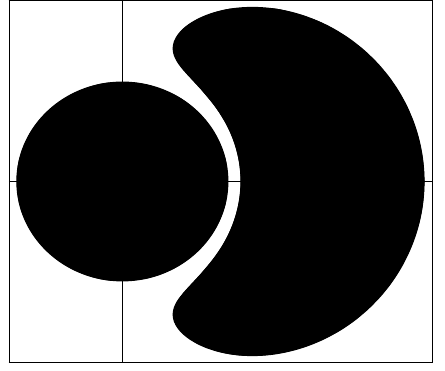
Figure 9 . Phase space distribution for upper-cap